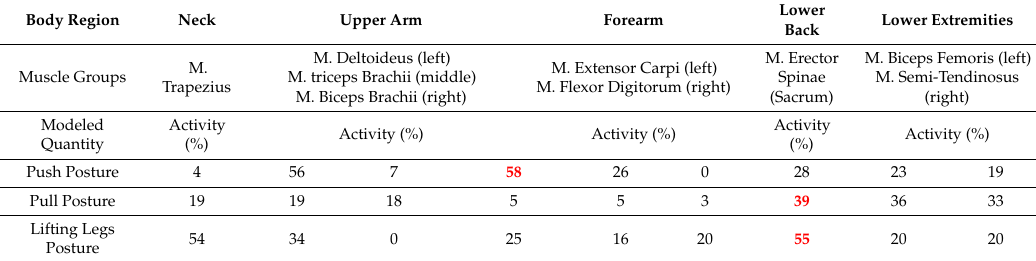
Table 1. Maximal muscle activities overall body regions.